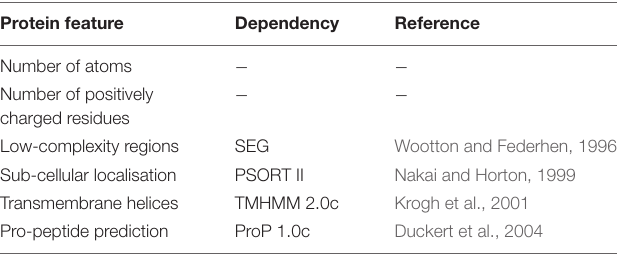
TABLE 2 | Protein features used in SecretomeP and the programs it utilizes internally to calculate them.